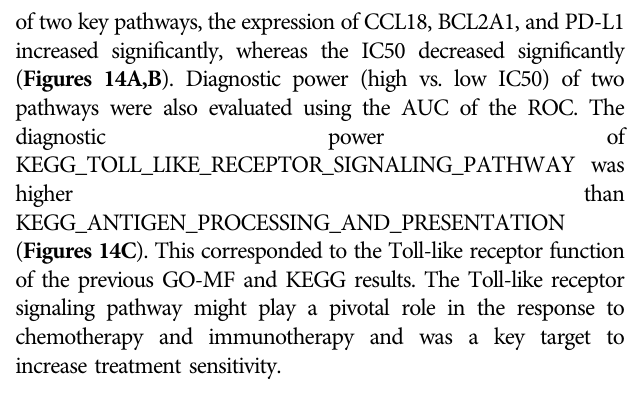
Frontiers in Cell and Developmental Biology |